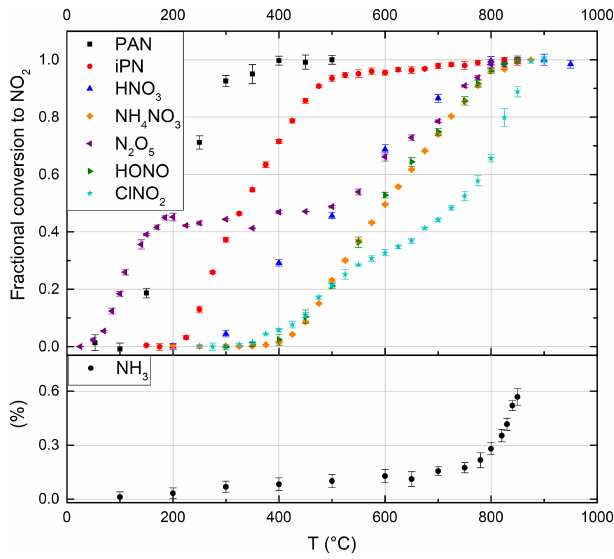
Figure 2. Thermograms of the NO z species PAN, iPN (isopropyl nitrate), HNO 3 , NH 4 NO 3 , N 2 O 5 , HONO, ClNO 2 and the poten- tial interference from NH 3 (without added O 3 ). The NH 3 fractional conversion is calculated relative to the calibrated output of the per- meation source, whereas all other species are calculated relative to the observed mixing ratio at maximum conversion. Error bars are derived from the standard deviations during the averaging intervals. At the set temperature of 850 ◦ C, PAN, iPN, NH 4 NO 3 , N 2 O 5 (x2), HONO and HNO 3 are converted quantitatively to NO 2 , while the NH 3 interference is negligible under typical ambient